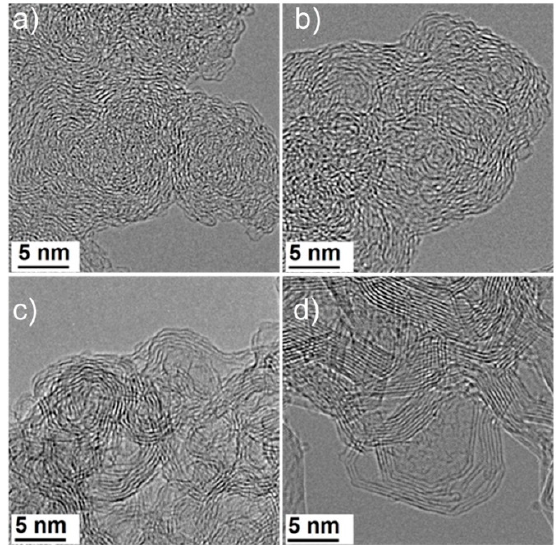
Figure 9. ( a ) Comparison of FW20 carbon black structure before and ( b ) after heat-treatment at 1000 °C, ( c ) 1700 °C, and ( d ) at 2600 °C. Reproduced with permission from Pawlyta et al. [47]. Copyright Wydawnictwo Politechniki Ś l ą skiej, 2017.